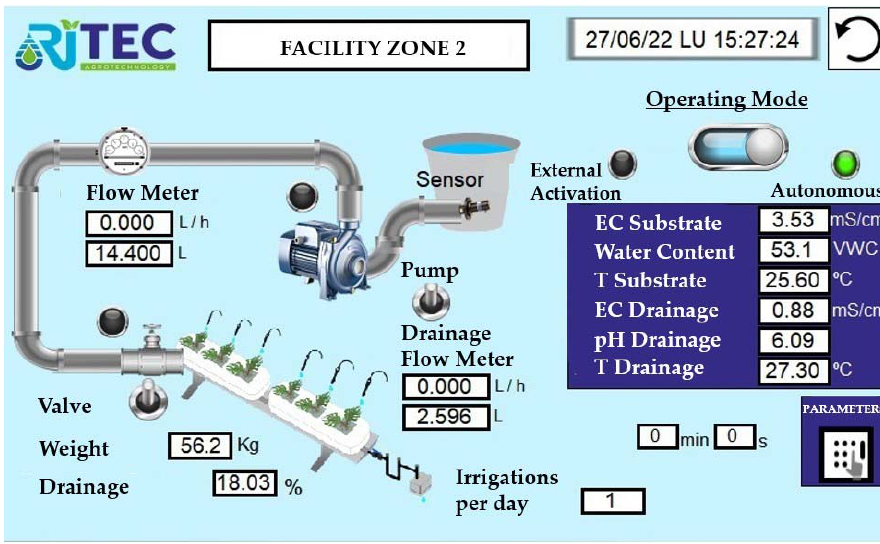
Figure A4. Screenshot example of HMI Visualization panel.